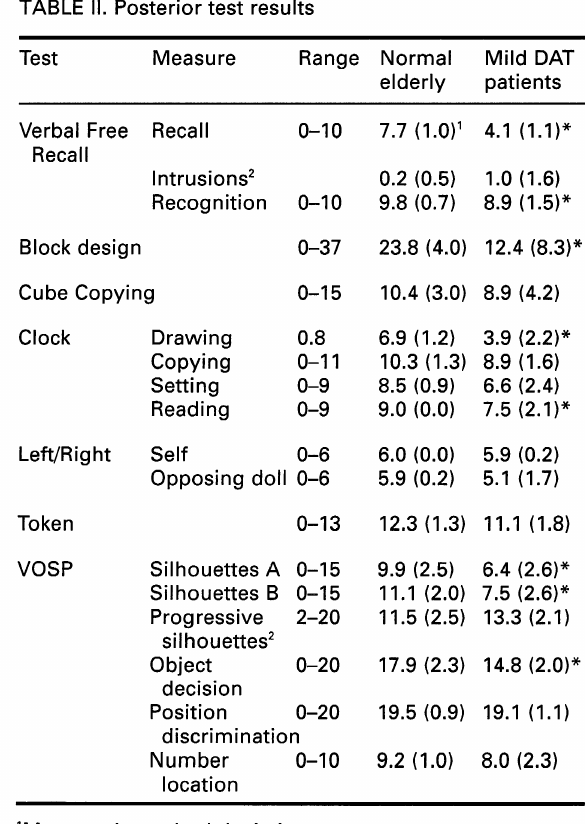
TABLE II. Posterior test